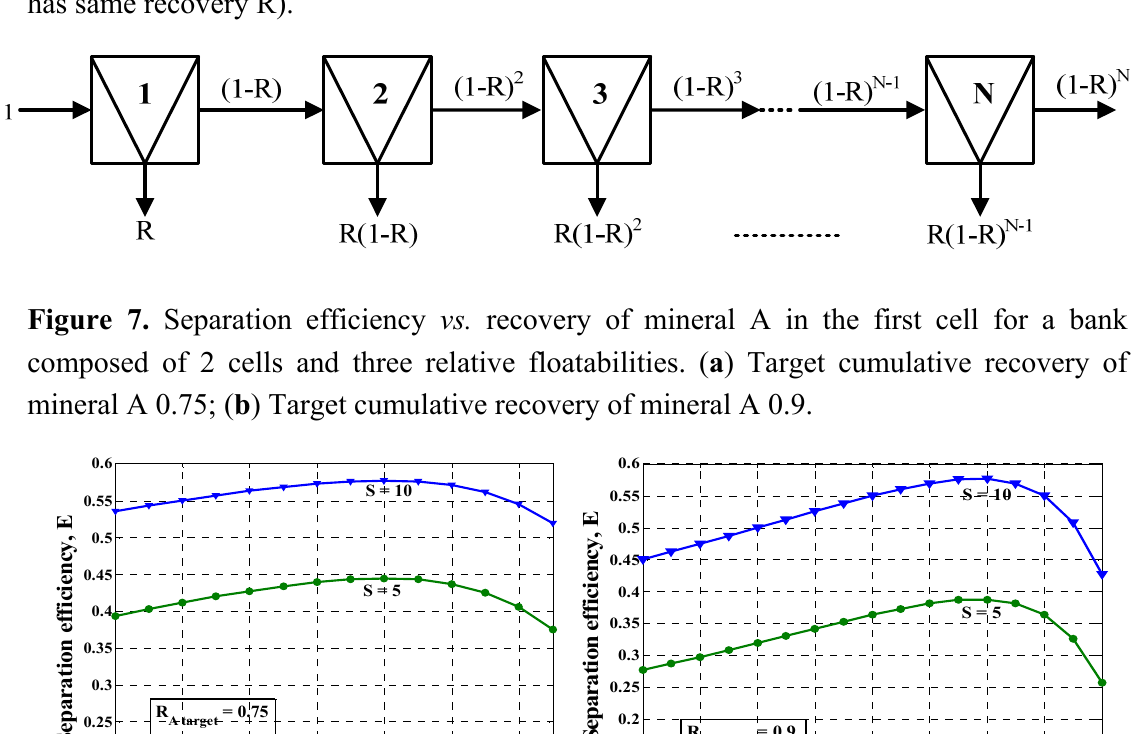
Figure 6. Optimal operation for two floatable minerals (flat recovery profile, i.e ., each cell has same recovery R).